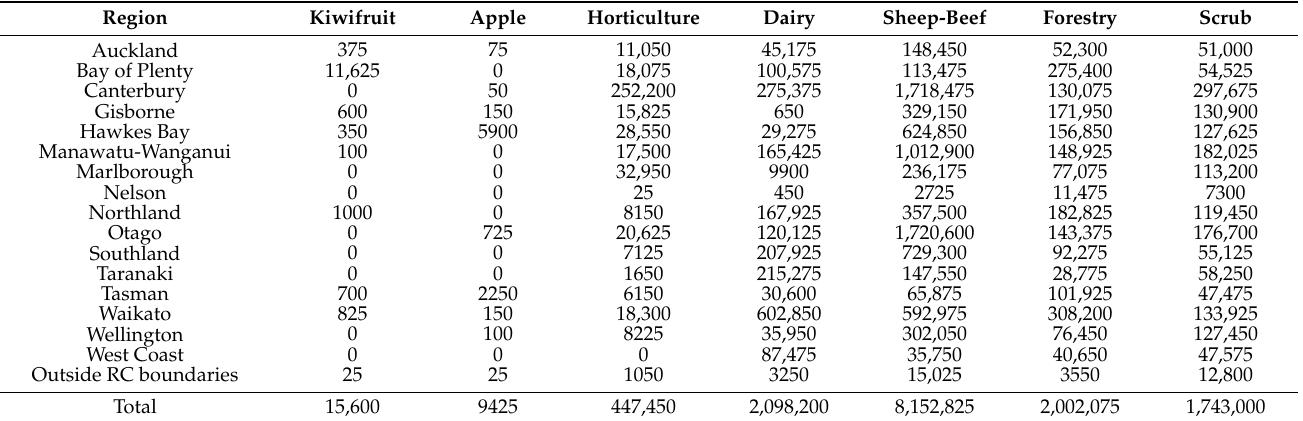
Table 4. Land use (ha) by region and outside regional council (RC)